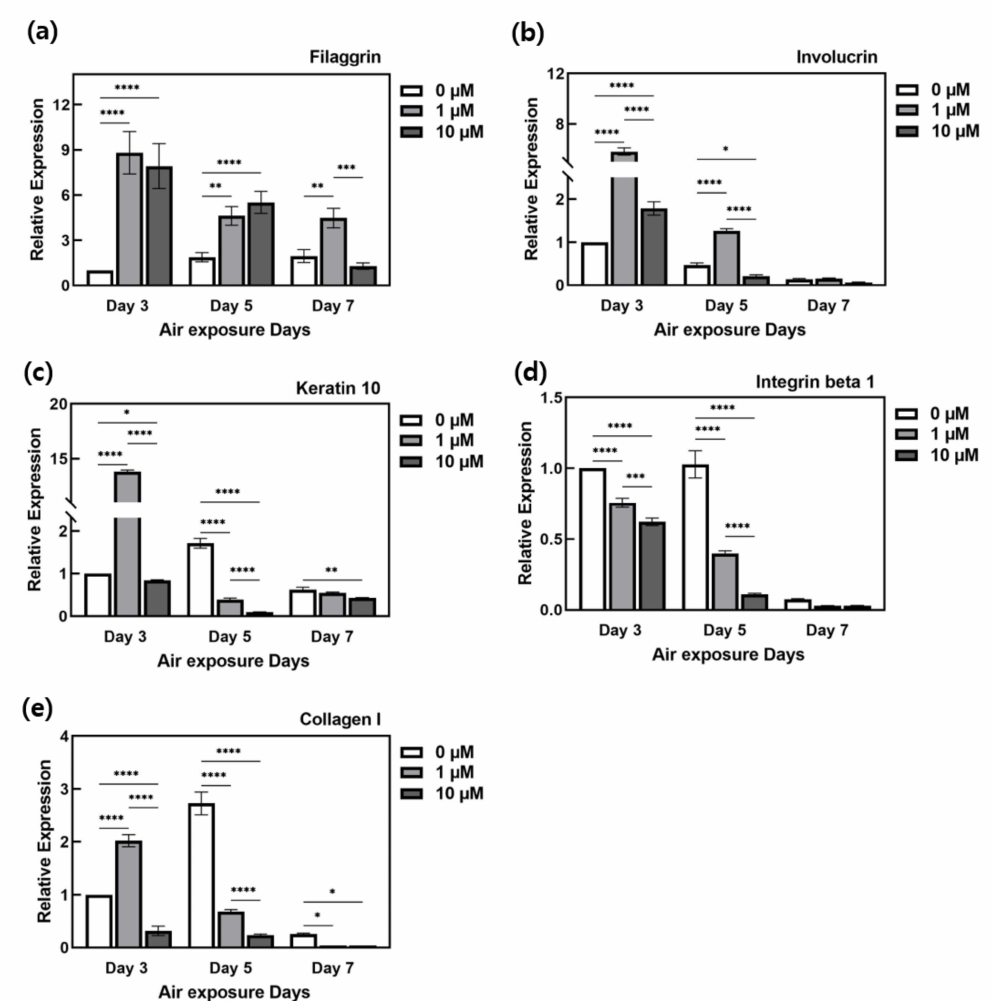
Figure 8. Relative gene expression of ( a ) filaggrin, ( b ) involucrin, ( c ) keratin 10, ( d ) integrin beta 1, and ( e ) collagen I with varing α -lipoic acid treated concentration and period by real-time q-PCR. It was quantified by relative comparison based on HSEs treated with 0 µ M α -lipoic acid for 3 days. ( n = 3; *, p < 0.05; **, p < 0.01; ***, p < 0.001; ****, p <